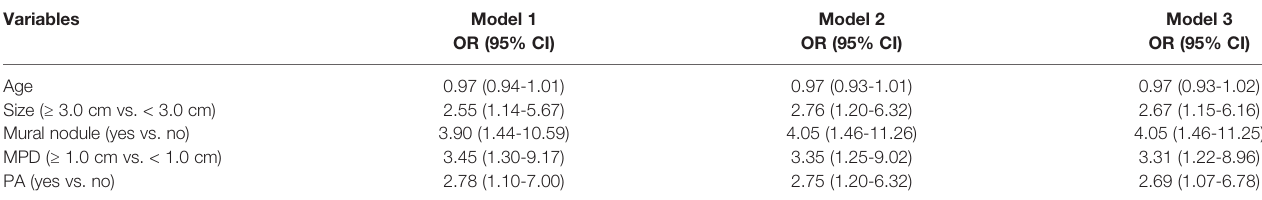
TABLE 2 | Associated factors with malignancy in